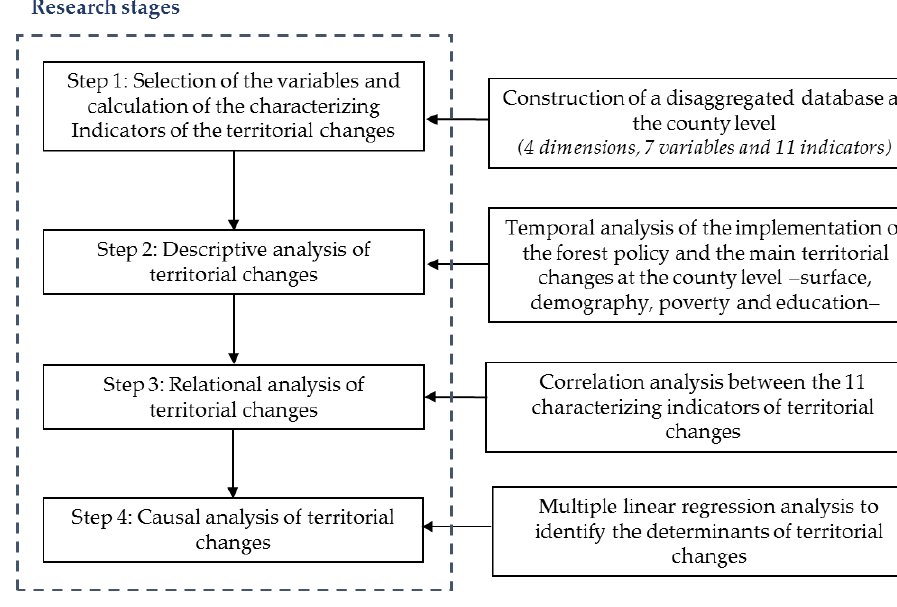
Figure 2. Flow diagram of the methodology used in the study.